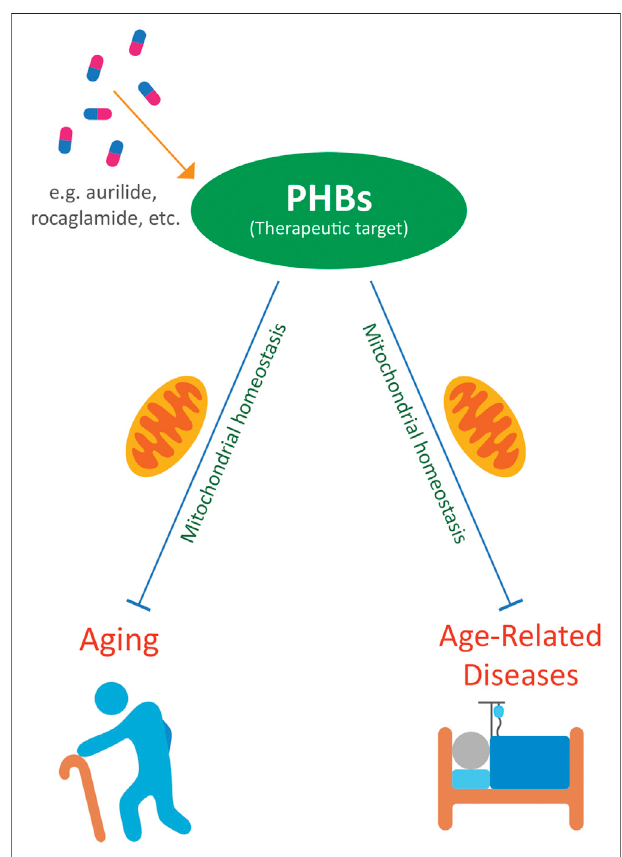
FIGURE 1 | PHBs as potential therapeutic targets to ameliorate aging and age-related